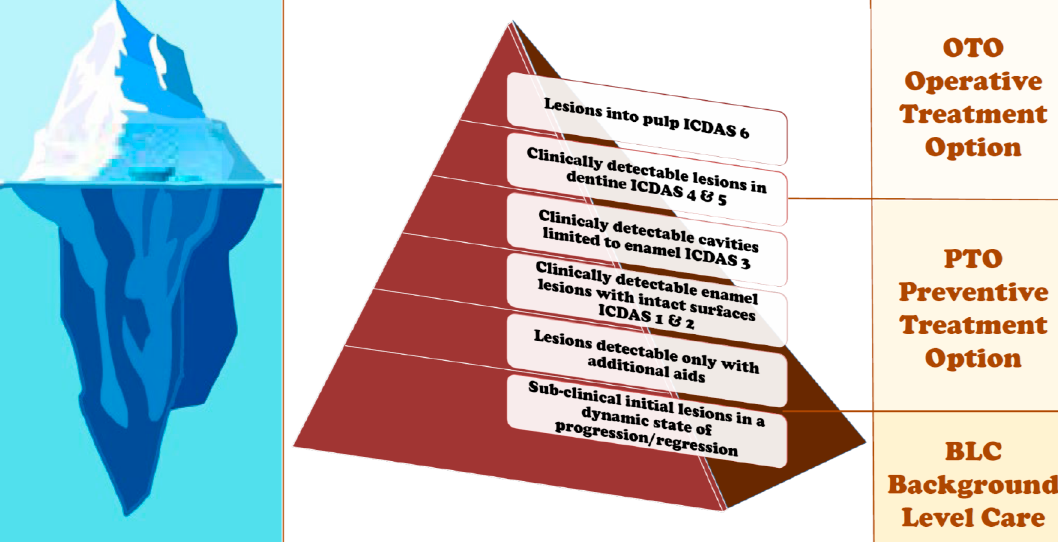
Figure 9. Scheme of the caries development pyramid (CDP) with indications ranging from background-level care (BLC) to preventive treatment options (PTOs) and the operative treatment option (OTO) in comparison with the general view of an iceberg submerged largely in water.